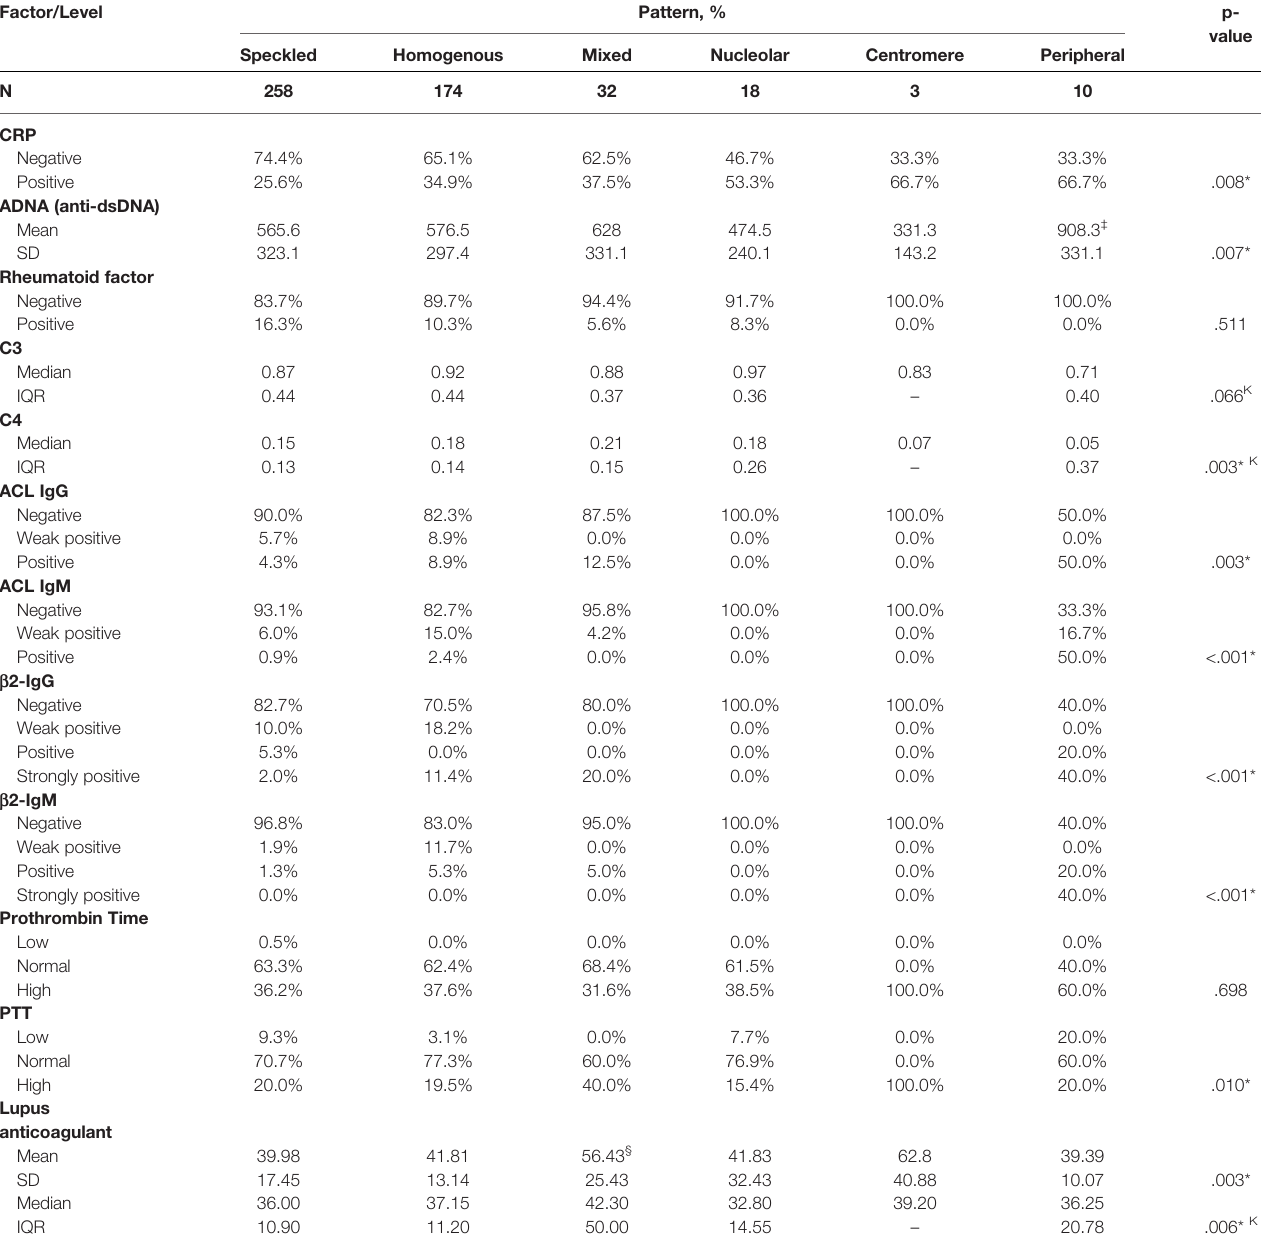
TABLE 5 | Association of ANA pattern with speci fi c and nonspeci fi c biological markers. Factor/Level Pattern, % p-